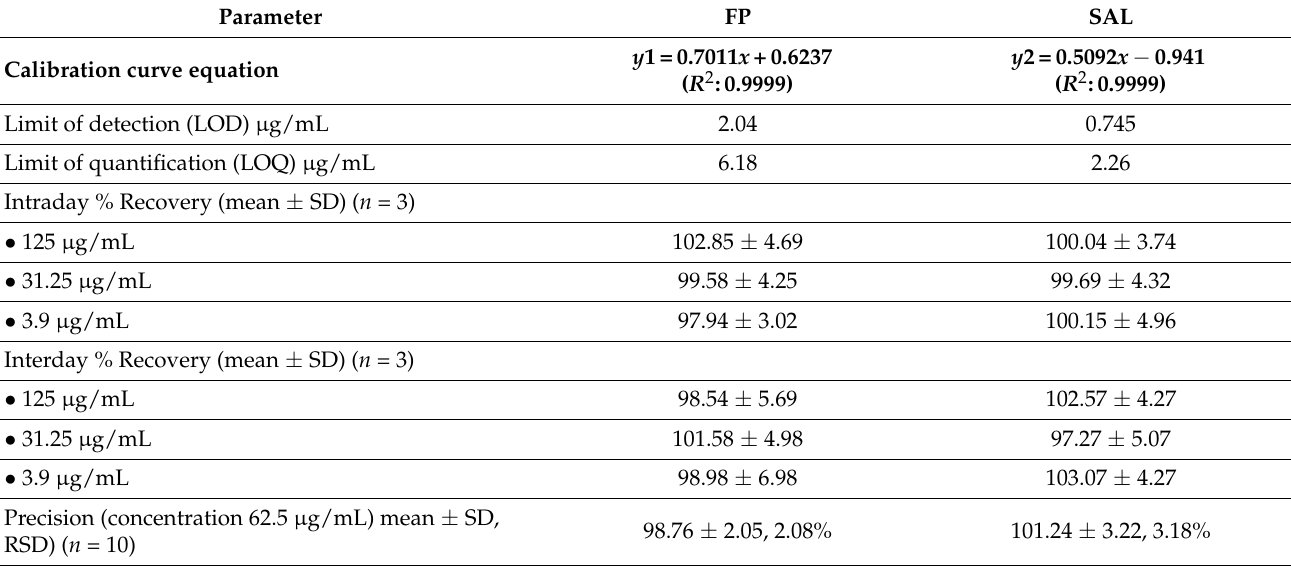
Table 2. Validation parameters of FP and SAL using the HPLC method.